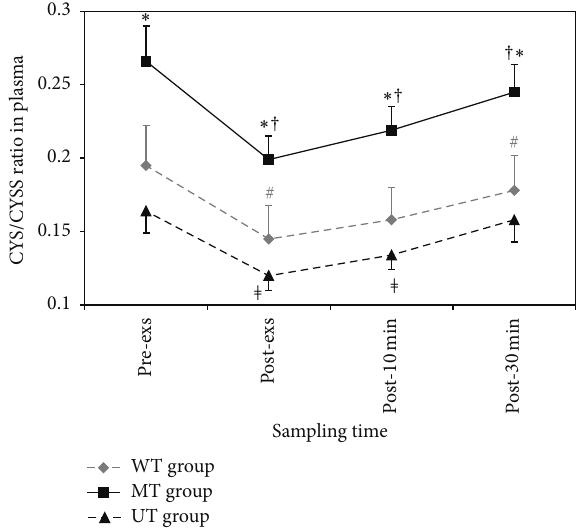
Figure 1: Effects of one session of aerobic exercise on plasma Cys/CySS in subjects with different physical training status. Values represent mean ± SEM ( 𝑛 = 10 ) for each time point. ∗ MT group versus WT and UT groups in pre-exs ( 𝐹 = 5.357, 𝑝 = 0.011 ), post- exs ( 𝐹 = 5.600, 𝑝 = 0.009 ), post-10min ( 𝐹 = 6.656, 𝑝 = 0.004 ), and post-30min( 𝐹 =5.403, 𝑝 = 0.011 );#WTgroupbytime( 𝑝 < 0.001 ); † MT group by time ( 𝑝 = 0.001 ); (cid:2) UT group by time ( 𝑝 < 0.001